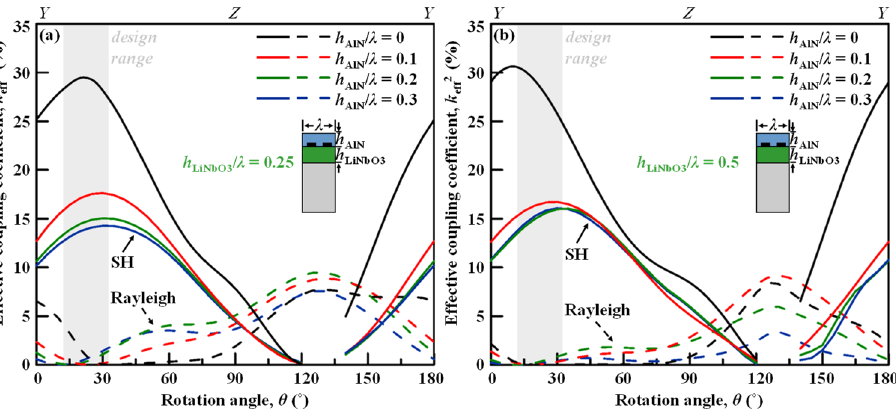
Figure 6. Calculated coupling coefficient k eff2 for varied thicknesses of AlN overlay layer on LiNbO 3 /Si across all rotation angles from the YX -LiNbO 3 with ( a ) h LiNbO3 / λ = 0.25, and ( b ) h LiNbO3 / λ = 0.5.